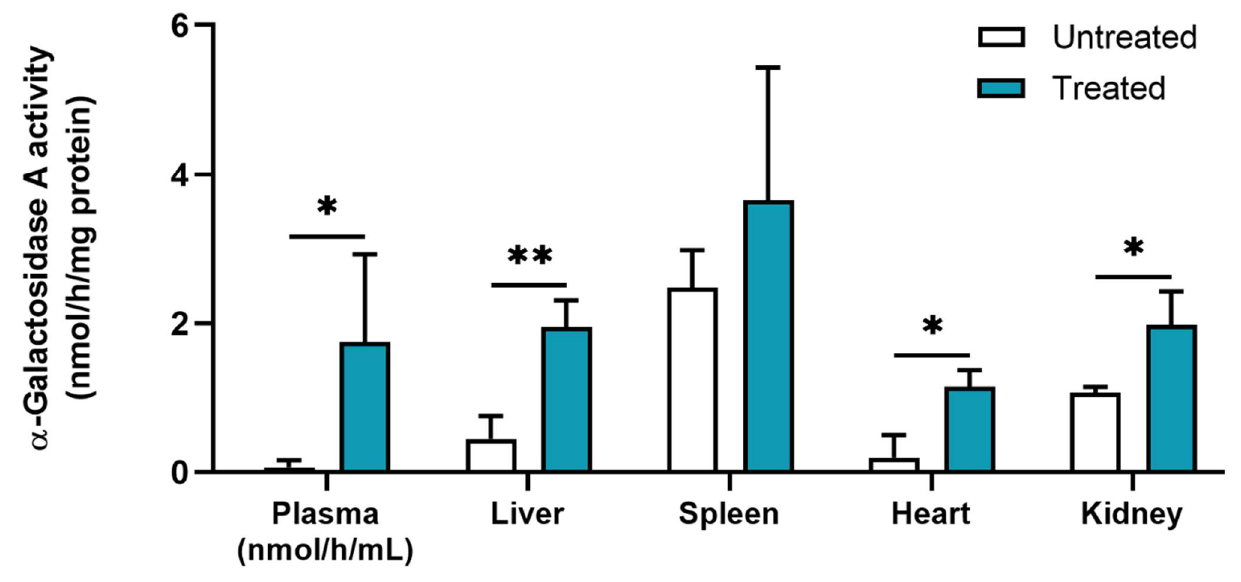
Figure 11. α -Galactosidase A activity in plasma and tissues of untreated and treated mice 5 days after the intravenous administration of the GM-SLN vector. One unit of α -Galactosidase A activity is equivalent to the hydrolysis of 1 nmol of the substrate 4-methylumbelliferyl- α -D-galactopyranoside in 1 h at 37 ◦ C. Results are shown as the mean ± standard deviation ( n = 3). Statistical significance: * p < 0.05, ** p < 0.01. Table 2. Percentage of α -Galactosidase A activity of wild-type mice in treated mice with the GM-SLN vector. Plasma Liver % of Wild-Type